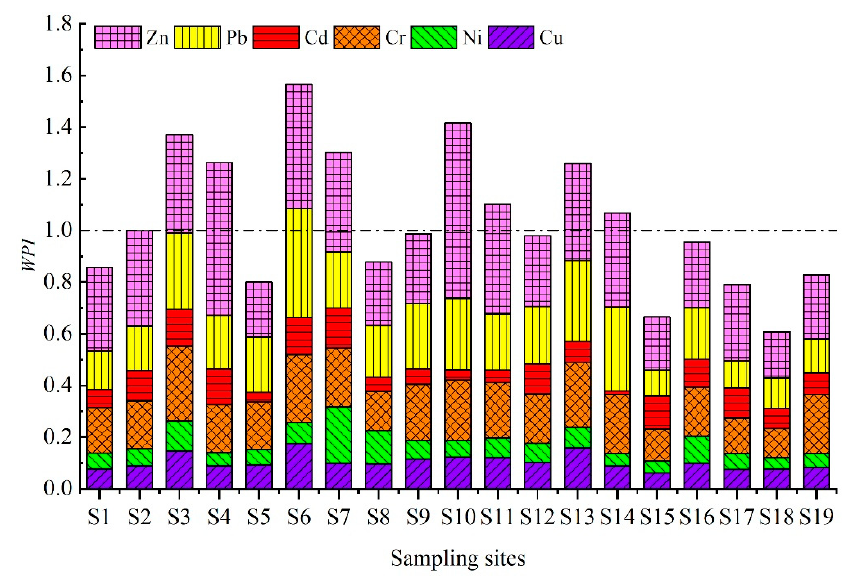
Figure 3. The comprehensive water pollution index of snow cover at each sampling site. The single-factor pollution index showed that the value of Zn ( P i = 2.07) reached the level of “moderate pollution”, and the sampling sites S4 ( P i = 3.54) and S10 ( P i = 4.07) were at the “high pollution” level (Figure 4). Although Zn is an essential trace element for plant growth, its high pollution level should be paid more attention. In addition, Cr and Pb in more than 70% of sampling sites were at the “low pollution” level, except Pb at S6, which was at the level of “moderate pollution”. There was a significant correlation among Zn, Cr, and Pb in snow cover (Table S5), indicating that they had similar pollution sources. The single-factor pollution indexes of the other three heavy metal elements were less than one, which indicated that the atmospheric environment of the Qixing River wetland was not greatly affected by Cu, Ni, and Cd.